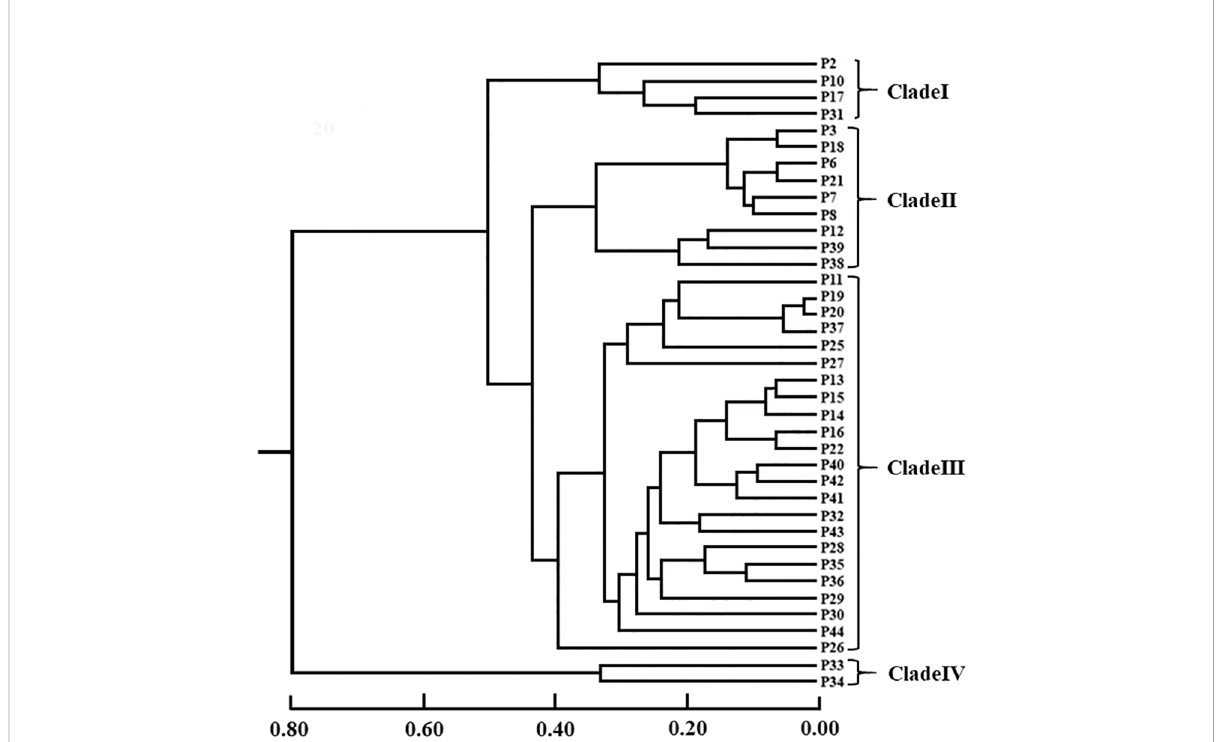
FIGURE 3 The UPGMA dendrogram of 38 populations of Wikstroemia monnula based on 12 SSR markers developed in this study. Scale bar represents the genetic distance. The brackets on the left marked four main clades, in which clade II and clade Ш include two subclades,